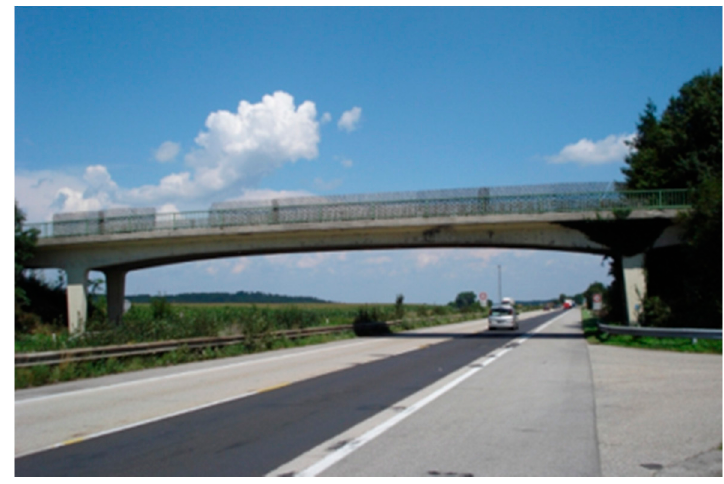
Figure 7. S101 bridge—West side [29].